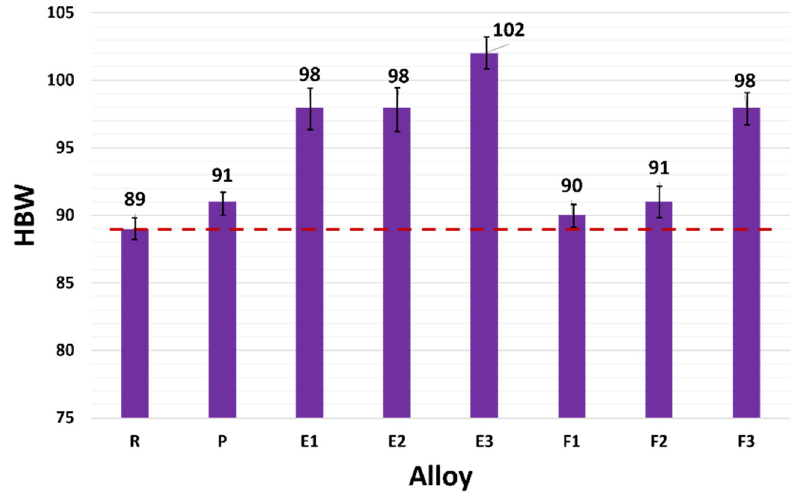
Figure 14. Dependence of HBW after heat treatment for R, P, and experimental alloys E1–E3 and F1–F3.